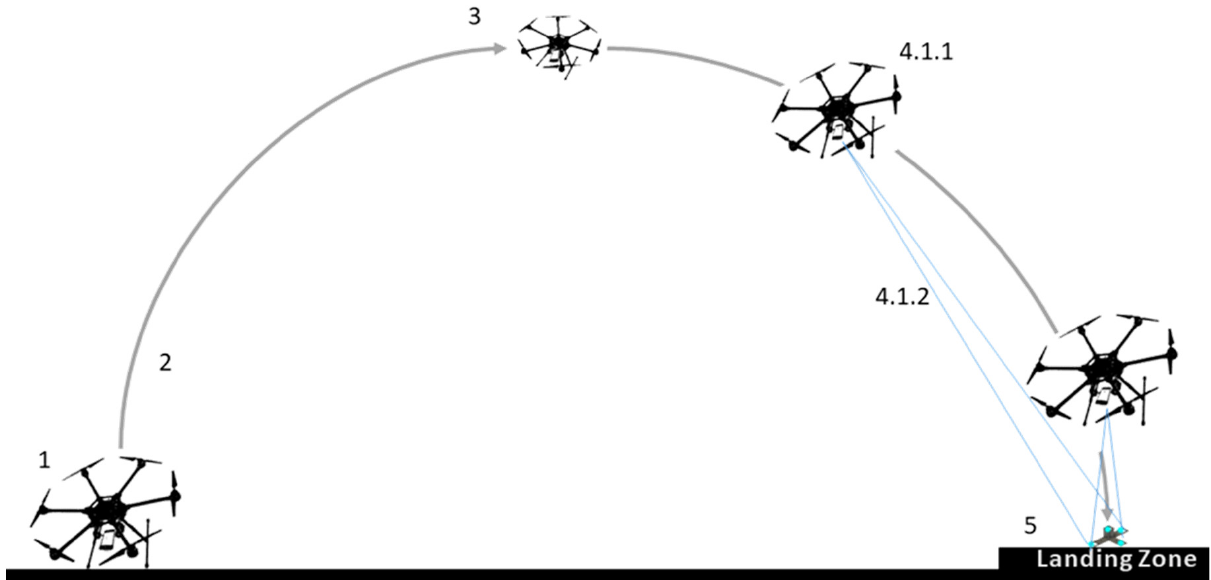
Figure 1. Drone landing mission using the Smartphone Video Guidance Sensor (SVGS). The mission